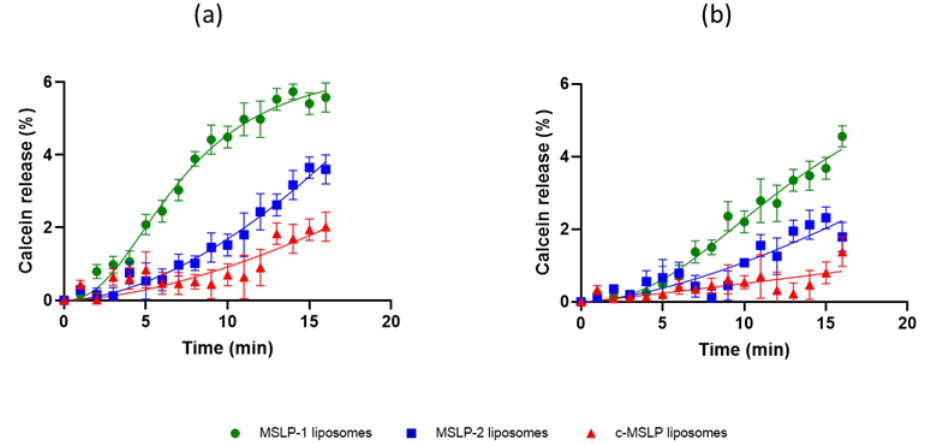
Figure 5. Calcein release from mApoE-MSLP-liposomes (1:10 MSLP:Sm, mass/mass) in presence of acti- vated ( a ) MMP2 or ( b ) MMP9. Curves were subtracted of calcein release values from calcein-loaded chol/Sm/DSPE-PEG2000mal-liposomes. Results are expressed as mean ± SD. One-way ANOVA found a significant effect of treatment (MMP2: F (5,96) = 5.6, p = 0.0001; MMP9: F (5,94) = 6.7, p < 0.001).